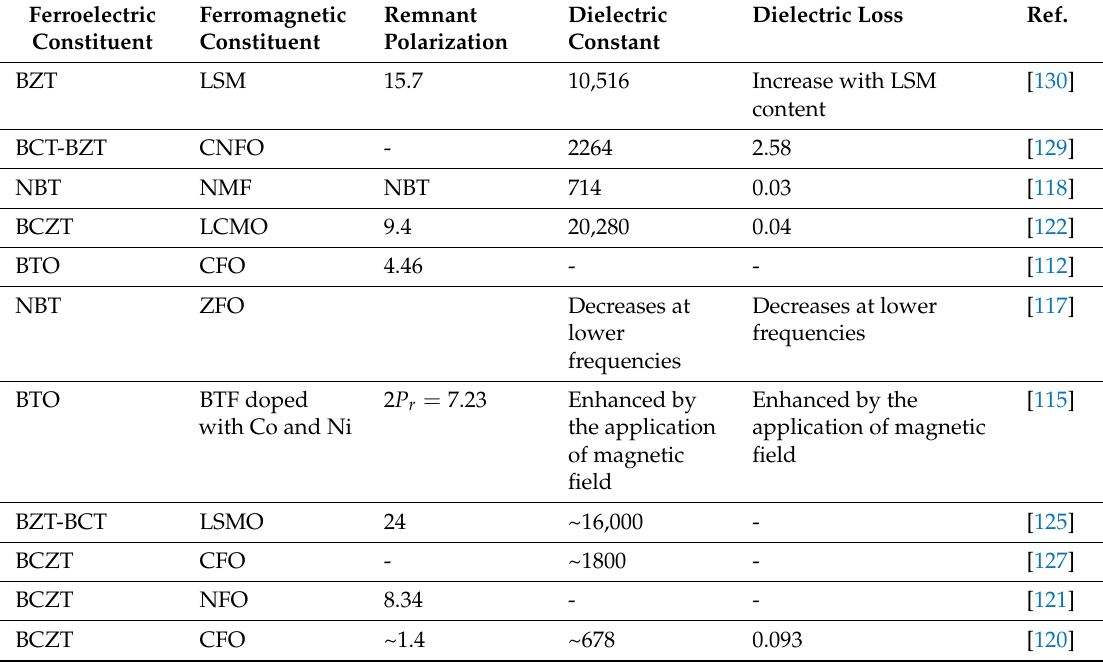
Table 3. Comparison of dielectric properties of di ff erent multiferroic